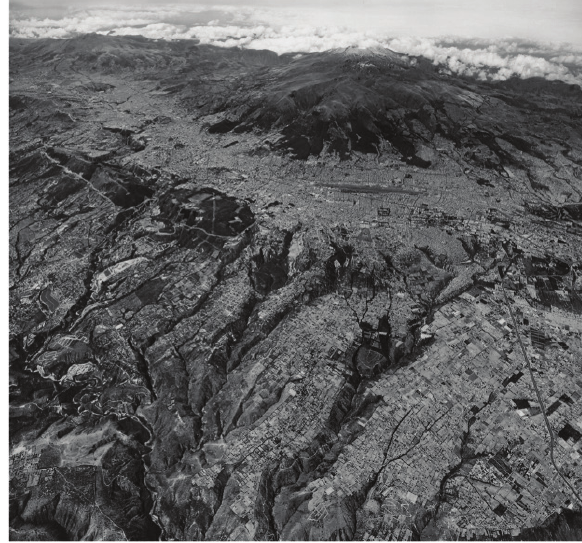
Figure 1. Aerial image of the MDQ, the upper and lower valleys and its complex topography (source: Correa, Felipe. Line in the Andes. Editorial: Harvard Graduate School of Design.